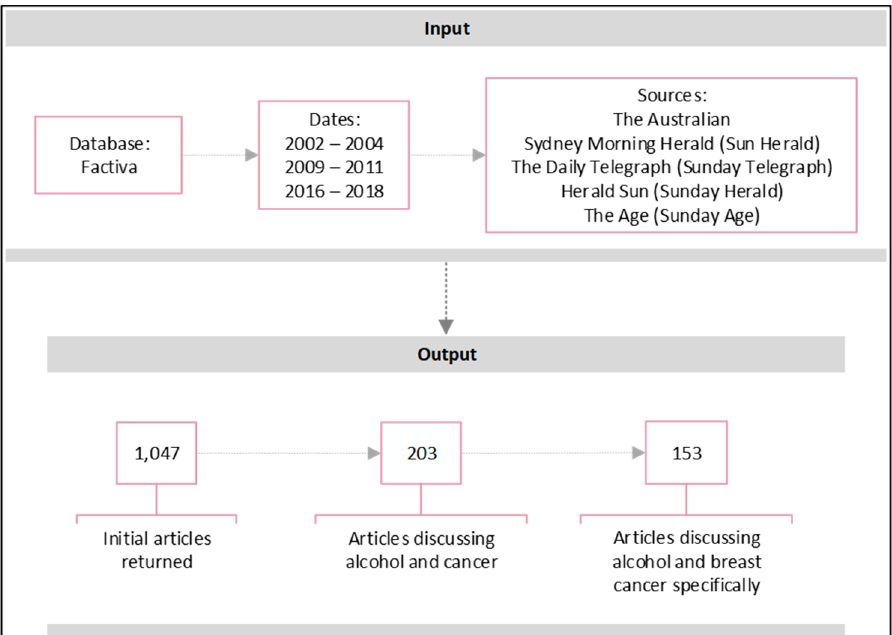
Figure 1. Input and output of Factiva database search.